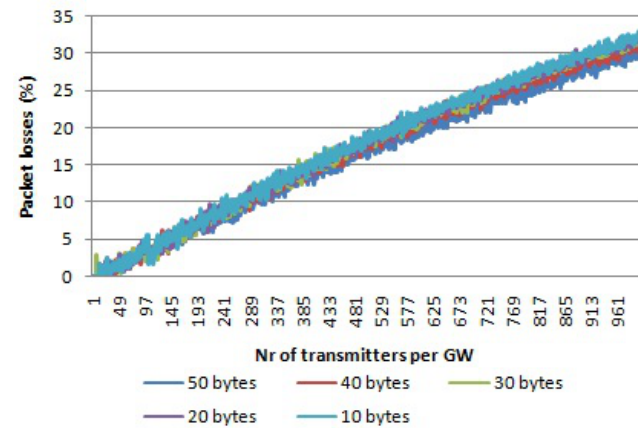
Figure 16. Comparison between different payload size. Multiple channels, multiple